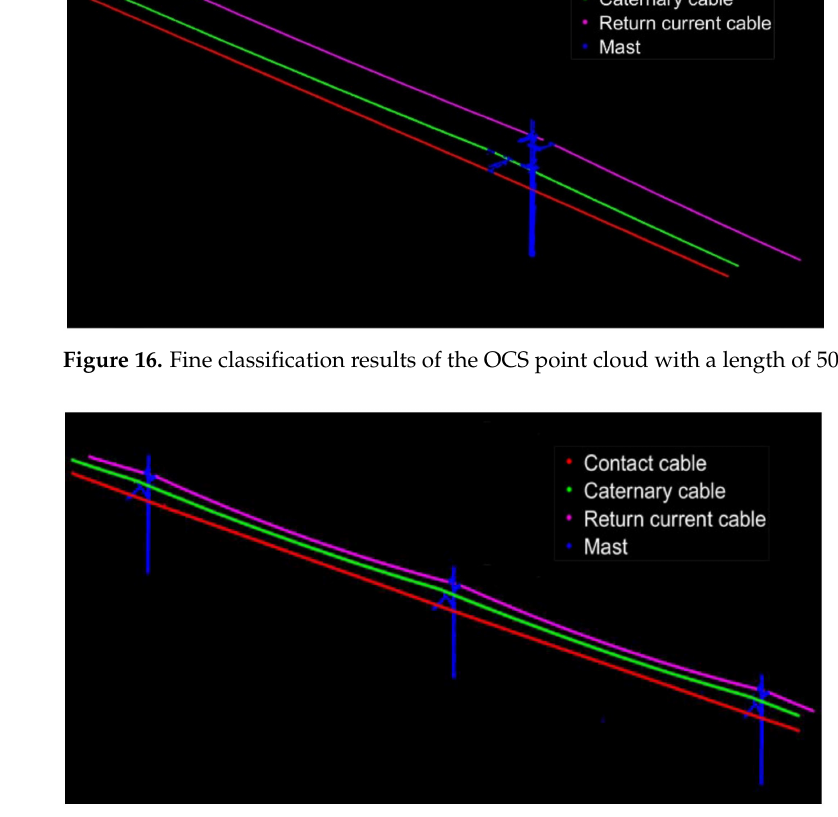
Figure 17. Fine classification results of the OCS point cloud with a length of 100